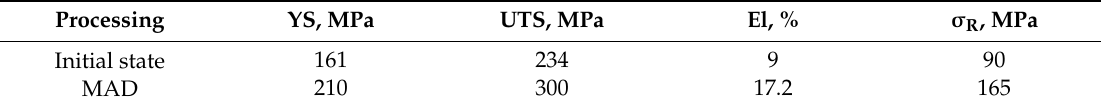
Table1. MechanicalpropertiesofalloyWE43intheinitialandpost-multiaxialdeformation(MAD)states. Processing YS, MPa UTS, MPa El, % σ R ,